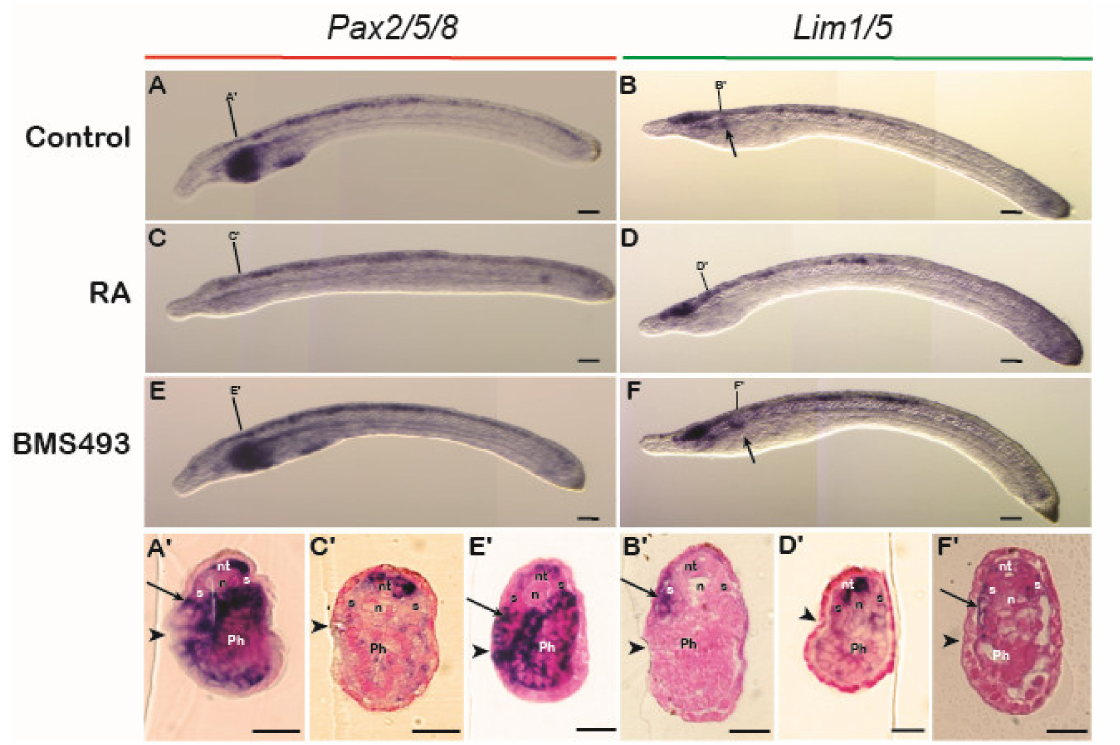
Figure 5. Retinoic acid signaling and the regulation of gene expression in Hatschek’s nephridium in amphioxus. Expression of Pax2/5/8 and Lim1/5 in control embryos at L0 ( A , B ) and in L0 embryos treated with retinoic acid (RA) ( n = 27/30 and n = 26/39, respectively) ( C , D ) or with BMS493, an inverse agonist of retinoic acid receptors ( n = 28/30 and n = 28/30, respectively) ( E , F ). Arrows in ( B , F ) indicate expression of Lim1/5 in Hatschek’s nephridium. Cross sections are at the level of the lines in the whole mounts. Arrows in ( A’ – F’ ) indicate expression in Hatschek’s nephridium. Arrowheads in cross sections highlight the mouth region. n, notochord, nt, neural tube, Ph, pharynx, S, somite. Scale bars in whole mounts are 50 µ m and scale bars in cross sections are 15 µ